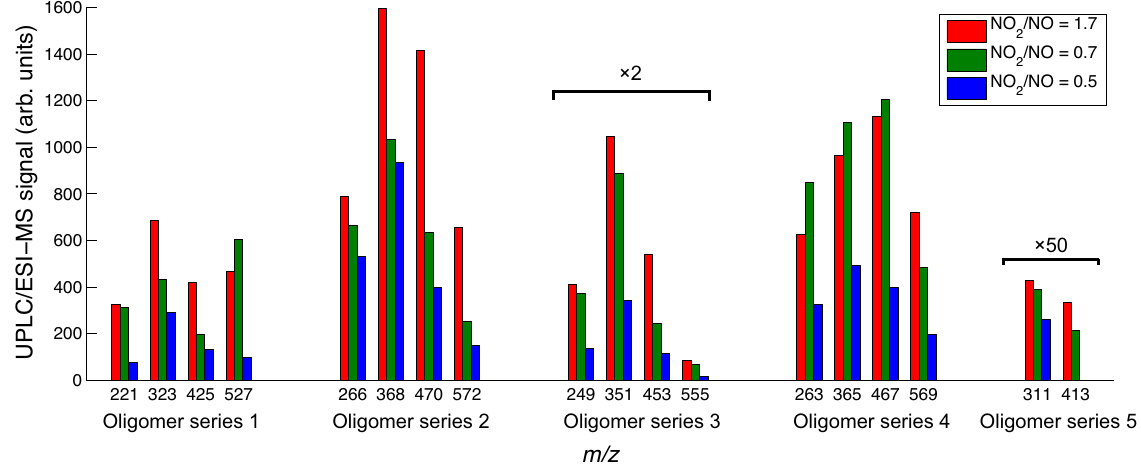
Fig. 7. Absolute peak areas (normalized by sampling volume) of all deprotonated ions detected by UPLC/(–)ESI-TOFMS in methacrolein/high-NO experiments, listed in Table 3. The positive dependence of oligoester abundance on NO 2 /NO ratios is consistent with the observed trend in overall SOA